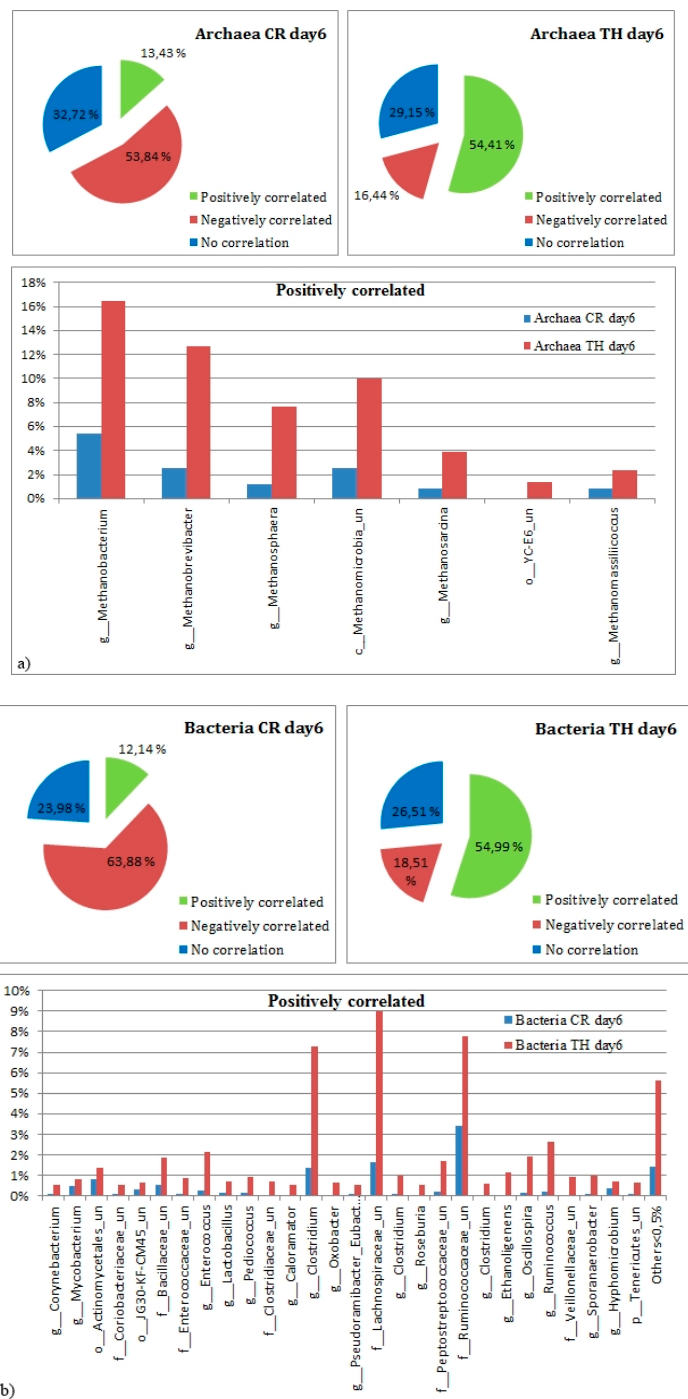
Figure 7. Relative abundances with detailed information on the classified OTUs positively correlated to the VFA production on day 6. ( a ) Archaea, ( b ) bacteria. Day 6 was chosen to be the one where highest VFA amounts were produced. Unclassified (un). For detailed abundance values and significance see the Supplementary Material